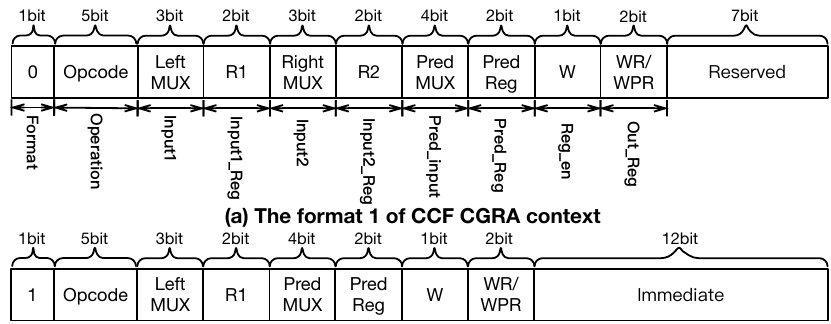
Figure 5. Two context formats of CCF